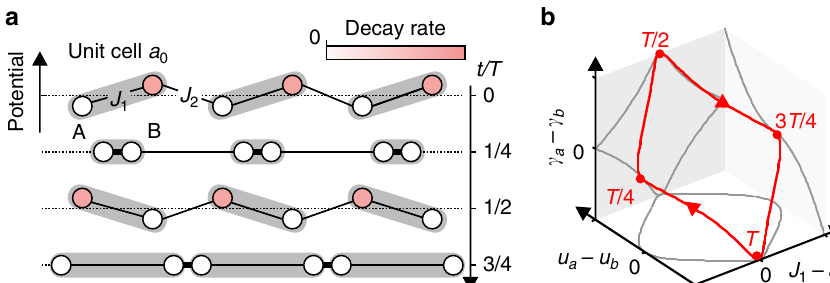
Fig. 1 Non-Hermitian driven Rice-Mele model. a Schematic of the periodically driven, NH RM lattice for four equidistant times during a pumping cycle. Lossy sites are depicted by red color, large (small) hopping amplitudes J 1,2 by short (long) distances between sites. b Pumping cycle in the parameter space ( J 1 − J 2 , u a − u b , γ a − γ b